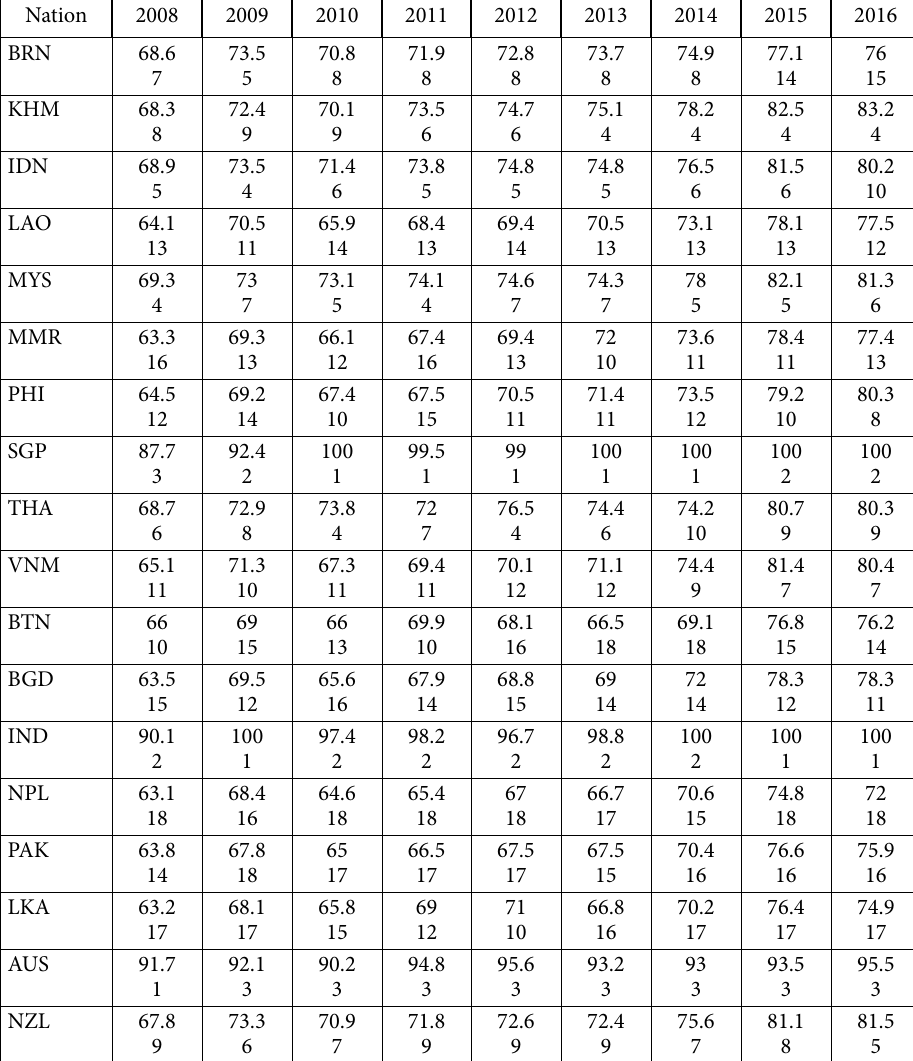
Table 3. Comparison of grey relational grades and grey relational ordinals among different nations (Unit: %; ranking)